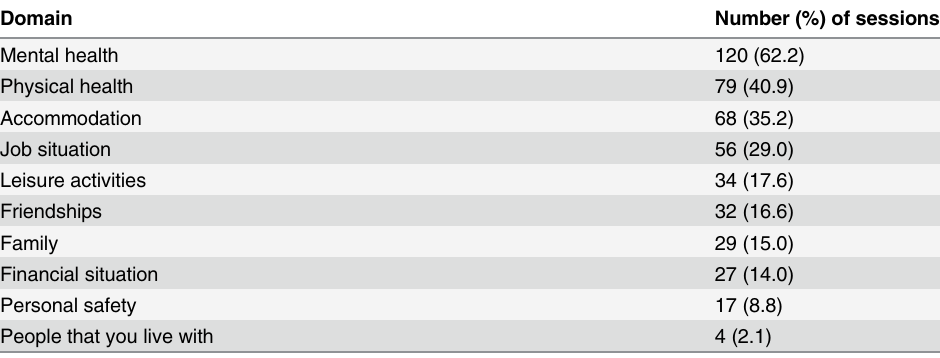
Table 2. The frequency with which each domain was discussed in DIALOG+ sessions.